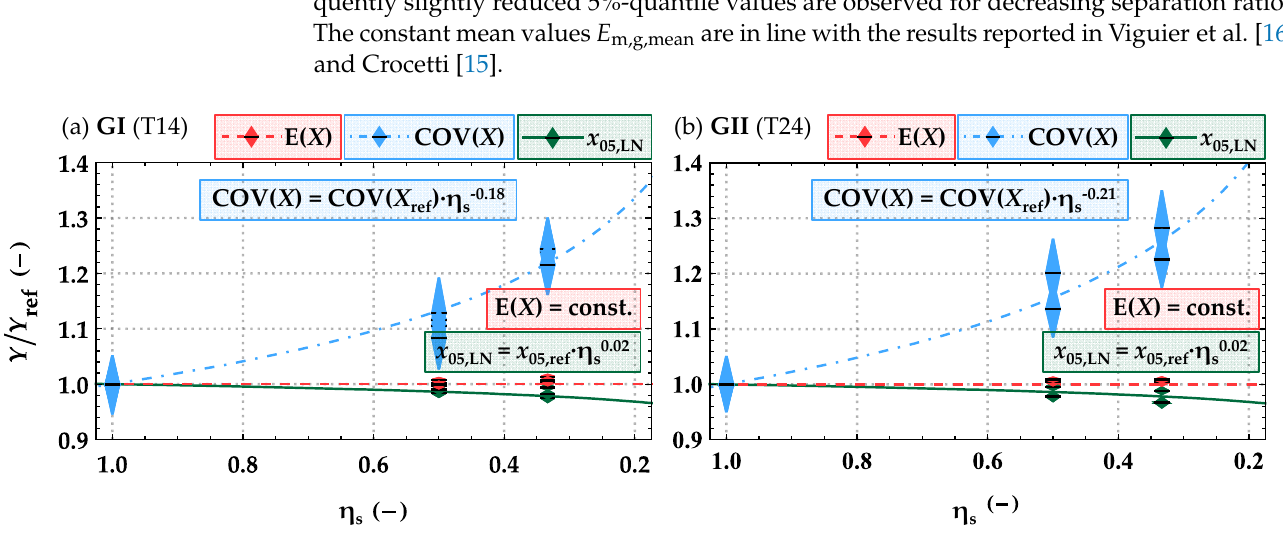
Figure 22. Influence of lengthwise splitting on the main statistics Y = {E( X ); COV( X ); x 05,LN } of the modulus of elasticity ( X = E m,g ) of resawn glulam relative to the statistics of the modulus of elasticity of glulam with full cross-section; glulam beams built up of virtually generated boards of GI ( a ) and GII ( b ).